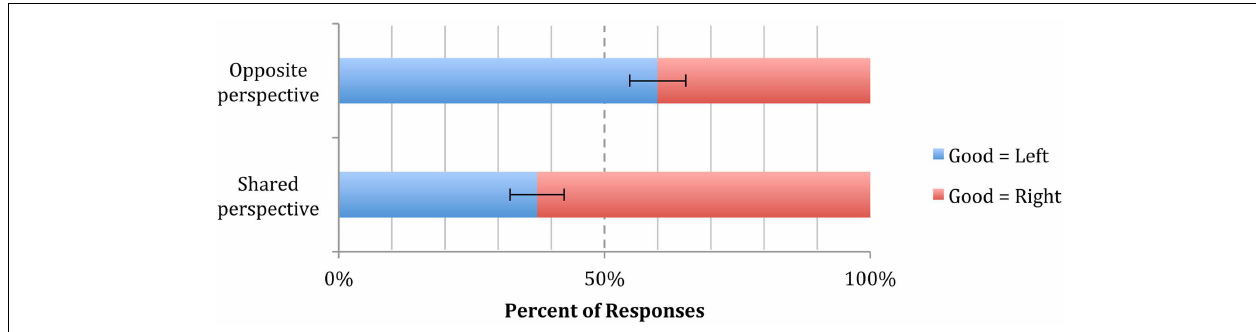
FIGURE 2 | Results of Experiment 1a .The dashed line at 50% represents chance responding. “Good = Left” and “Good = Right” are coded from the participant’s perspective. Error bars indicate SEM.